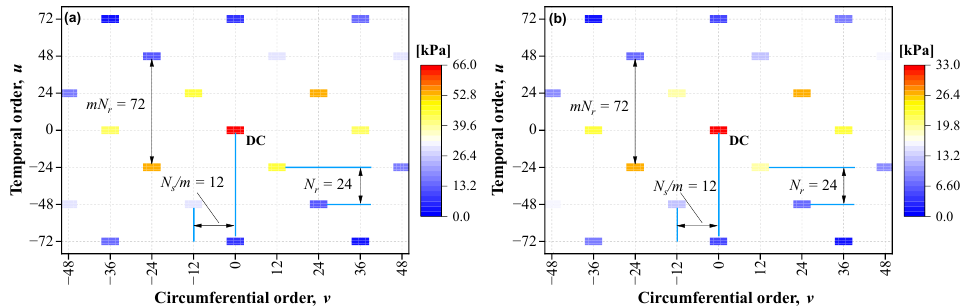
Figure 12. Dominant radial force density harmonics of the 36/24 SRM at ( a ) 950 RPM and ( b ) 3400 RPM.